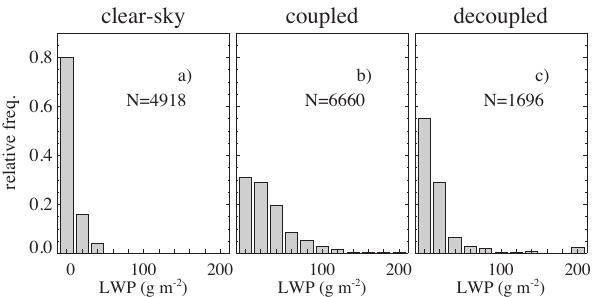
Fig. 10. Frequency distributions of the (a) LWPs in clear-sky con- ditions (i.e., neither the lidar nor radar provided a valid return), and when only the lidar detected cloud under (b) coupled (CBH-LCL < 125 m) and (c) decoupled (CBH-LCL > 125m) conditions. LWP bins of 20gm − 2 .